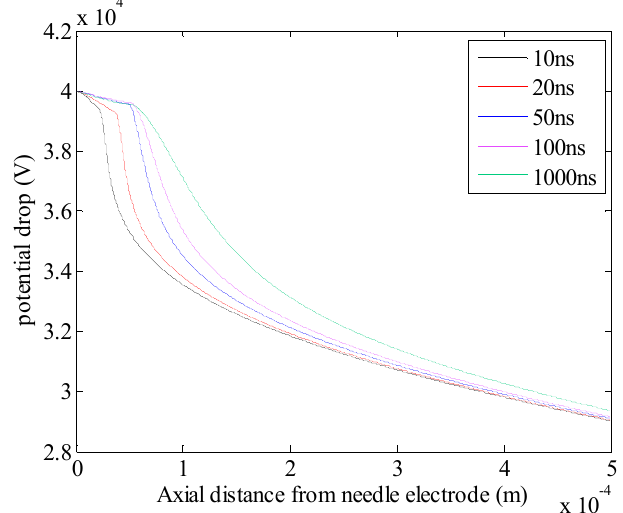
Figure 16. Potential distribution along the needle-sphere axis as a response to 1.2 PDIV with 5 mm needle-sphere electrode configuration.